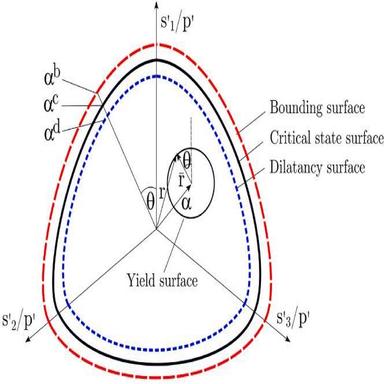
BSPM Shapes of the model surfaces in the deviatoric plane.